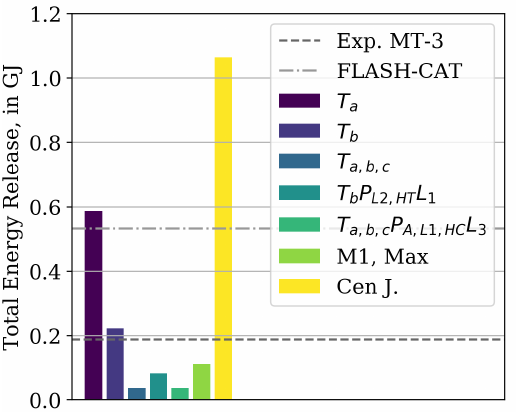
Figure 9. Total energy release of the MT3 simulations, as compared with the experimental values and results form the FLASH-CAT (FC) model.